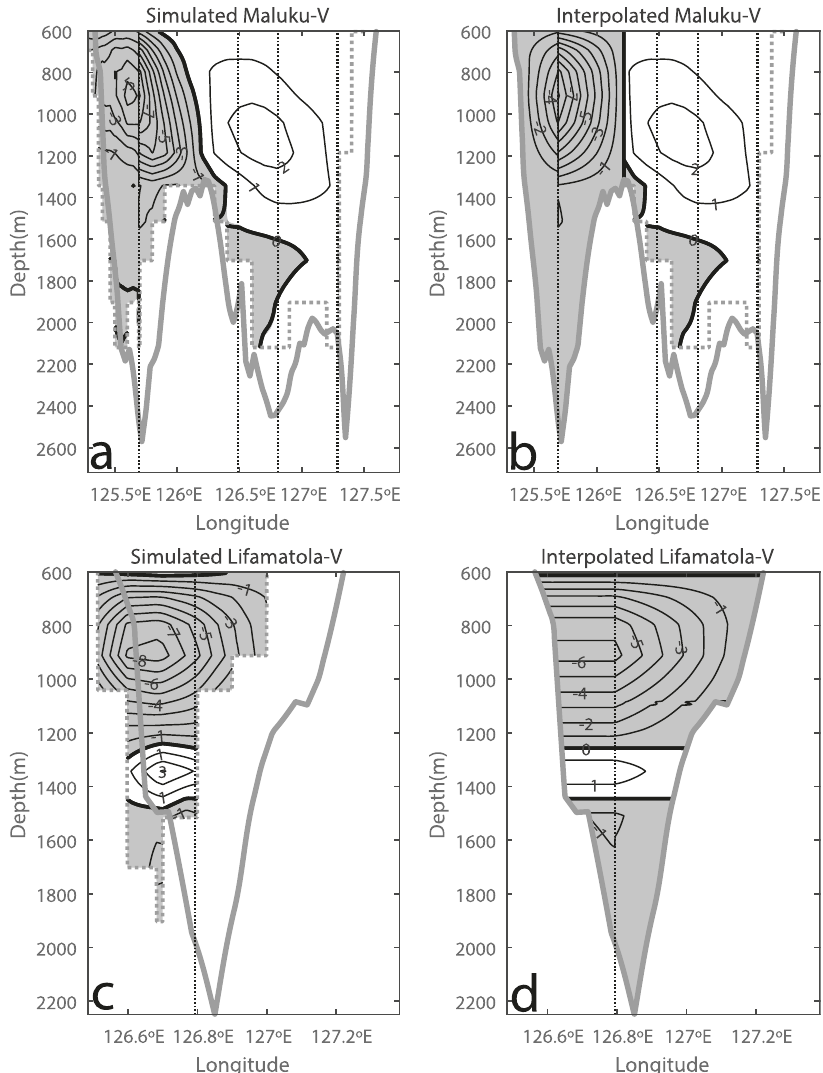
Fig. 3 Current por fi les in the Maluku Channel and the Lifamatola Passage. a OFES model simulated mean currents, through the Maluku Channel normal to a coast-to-coast section along 2°N, and ( b ) the interpolated WBC from simulated M01 data using the nonslip boundary condition on both sides of the western Maluku Channel, respectively; c simulated mean currents through the Lifamatola Passage normal to a shortest coast-to coast section, and ( d ) the interpolated currents using the freeslip and nonslip conditions on the western and eastern coasts, respectively, showing good approximation of the interpolated to the simulated currents. Unit is cm s − 1 . The simulated and interpolated transports between 600 m and 1200 m are 2.08 Sv and 1.75 Sv, respectively, for the WBC ( a , b ), whereas 1.25 Sv and 0.96 Sv, respectively, through the LF Passage ( c , d ). The dash stairs stand for model topography. The thick contours in the Maluku Channel section and the Lifamatola Passage section are the water depths from the ETOPO2v2